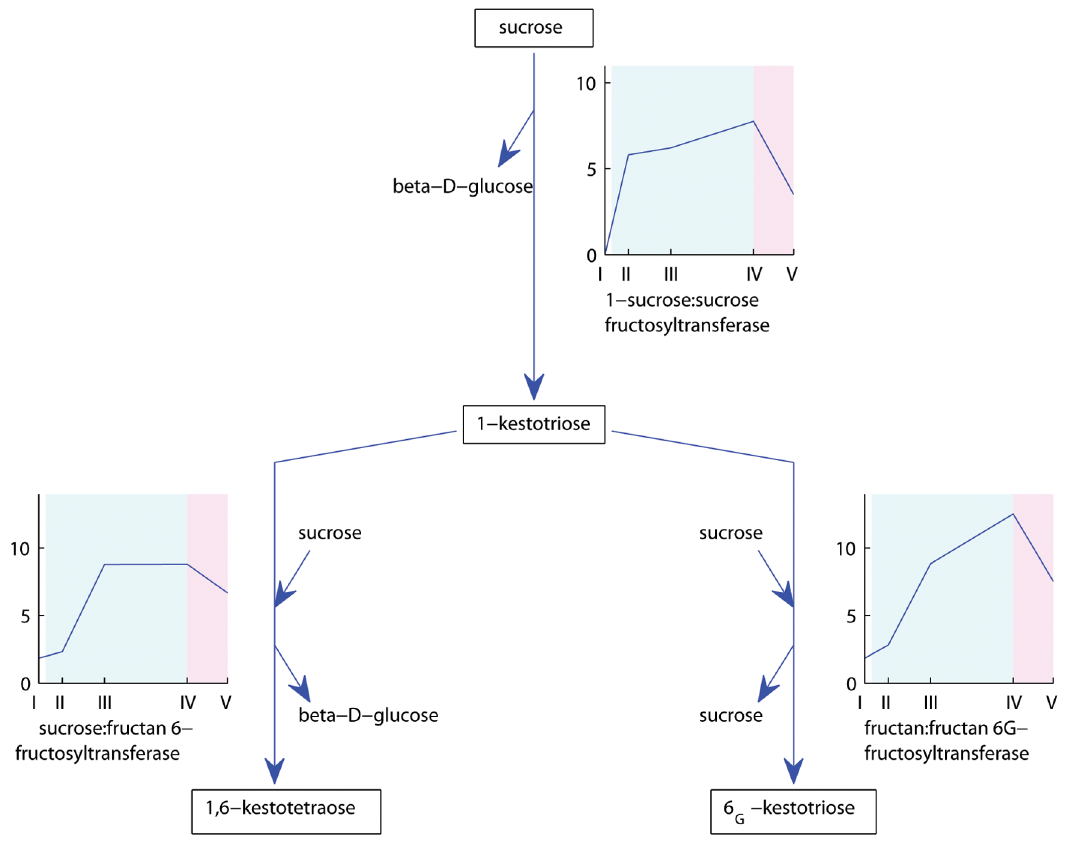
Figure 7. Expression profiles of Falster and Veyo transcripts involved in fructan biosynthesis. Falster transcripts are depicted in blue, Veyo transcripts in red. The x axis presents the sample collection time points: I= autumn conditions, before the start of vernalization; II=2 days of vernalization; III=4 weeks of vernalization; IV=9 weeks of vernalization; V=7 days of long day conditions. The y axis corresponds to the variance stabilized data from DESeq. The blue background illustrates vernalization treatment, the pink background illustrates long day conditions. Figure adapted from the Plant Metabolic Pathways database (http://www.plantcyc.org/).